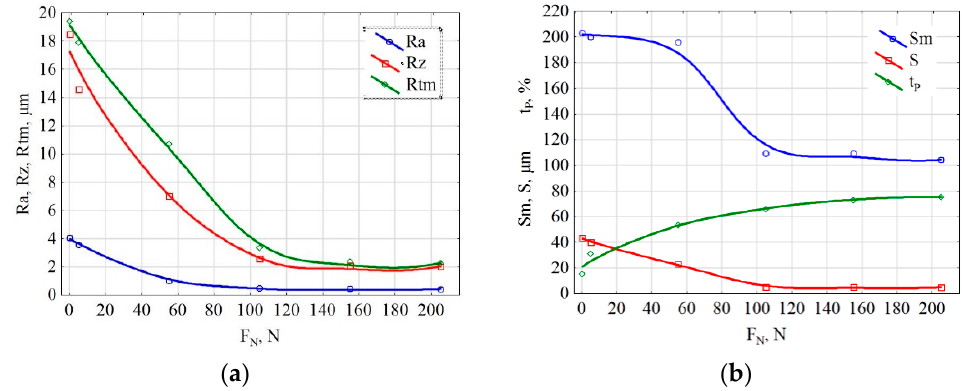
Figure 6. Functions of changes in height Ra, Rz, Rtm ( a ) and stepSm, S, tp ( b ) roughness parameters from the pressing force of the deforming element.